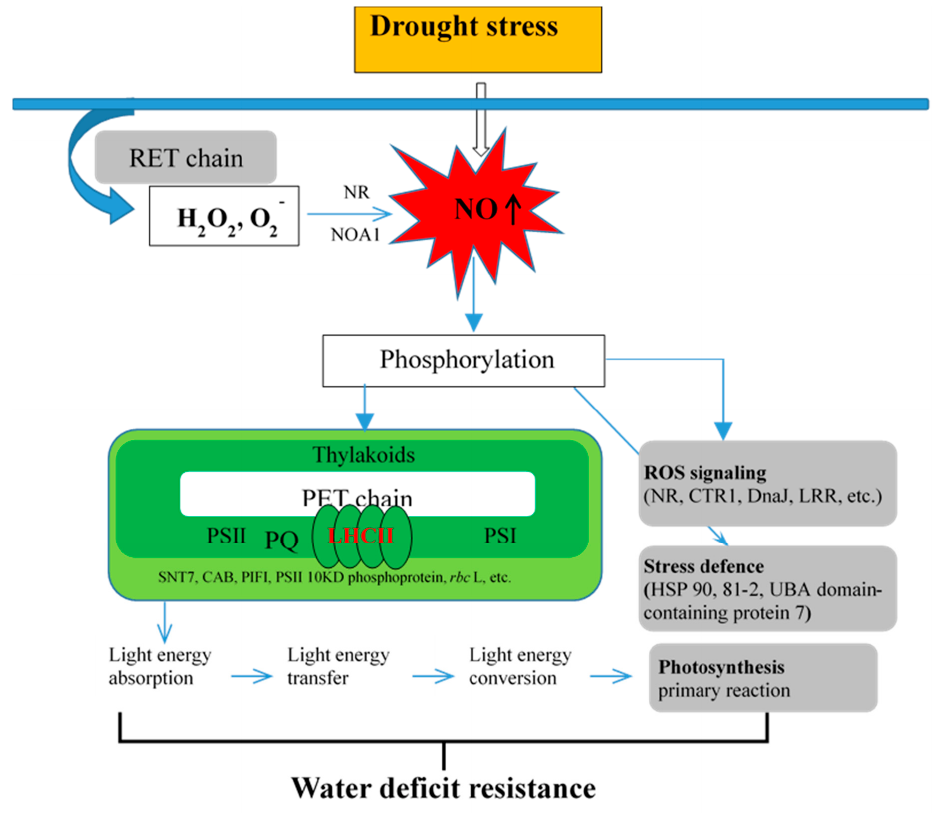
Figure 6. Schematic representation of NO involved in the regulation of photosynthesis to improve water-deficiency stress resistance. The contribution of NO to photosynthesis primary reaction under water deficit stress flows in the direction indicated by the arrow.